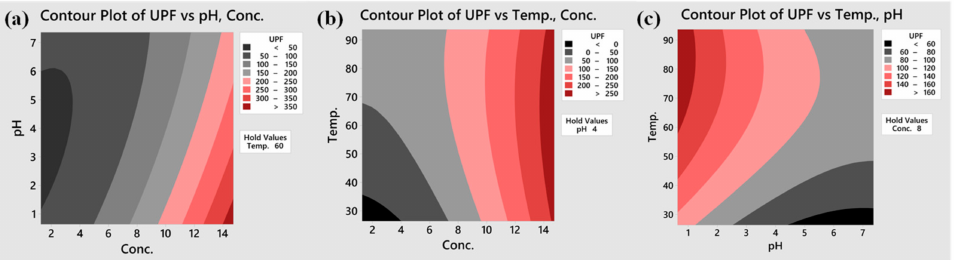
Figure 5. Contour plots for UPF as function of dual factors: ( a ) TA concentration vs. pH, ( b ) TA concentration vs. temperature, and ( c ) pH vs. temperature.